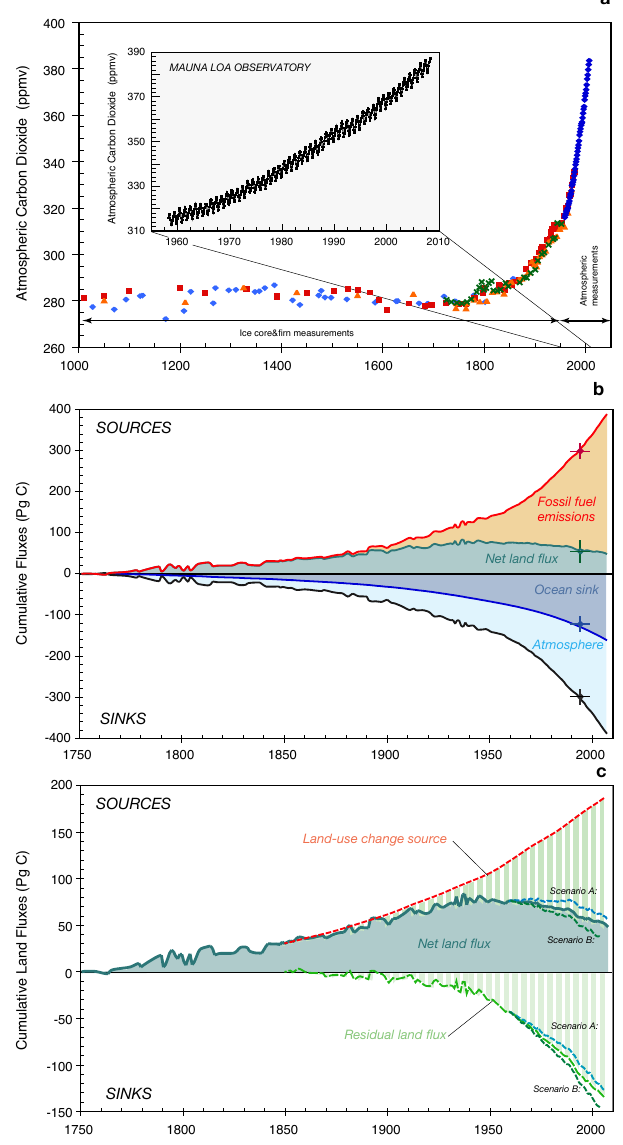
Fig. 5. Atmospheric CO 2 and the cumulative carbon budget starting from 1750. Sources for data are as described in Appendix A with additional sources given in the caption. (a) Atmospheric CO 2 variations over the last 1000 years. The data until 1958 stem from a series of Antarctic ice cores (Barnola, 1999), while the data from 1958 onward are from the Mauna Loa Observatory in Hawaii. The inset shows the monthly Mauna Loa measurements, whereas the main plot depicts the annual means. (b) Cumulative carbon fluxes from 1750 onwards of the main sources and sinks of the global carbon cycle including fossil fuel emissions, the atmospheric CO 2 increase, ocean uptake, and net land flux. The atmospheric increase is calculated from a spline fit to the ice core and Mauna Loa CO 2 data from (a), the ocean uptake is based on the ocean inversion of Mikaloff Fletcher et al. (2006) scaled to the respective year assuming a linear relationship between ocean uptake and atmospheric CO 2 (see Appendix A) and the net land flux is computed by the difference Net land flux = fossil fuel emissions – atmospheric CO 2 increase – ocean uptake. The symbols are estimates from Sabine et al. (2004) for the period from 1800 to 1994 summed to the 1790 to 1810 average of our estimates. (c) The cumulative net land flux from panel (b) (solid blue line) plus two additional scenarios for the net land flux based on the oceanic uptake estimates of Le Qu ´ er ´ e et al. (2007; Scenario A) and Wetzel et al. (2005; Scenario B) which represent upper and lower limits of the ocean uptake estimates from Fig. 1b, respectively. Also shown in the figure is the cumulative land use source of Houghton (2007) for the period 1850 to 2005, which is summed in this figure to the 1850 net land flux. The total area under this curve including the vertically hatched green area and the solid light green area is our best estimate of the total land use change sources of CO 2 to the atmosphere. The solid green area is that portion of the source that can be accounted for by the carbon budget in panel (b). The vertically hatched area thus must be balanced by the additional sinks shown in the lower part of this